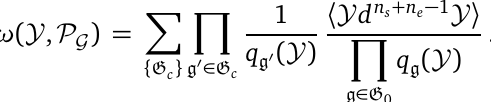
Figure 5: Higher codimension intersections of the facets outside P graphically obtained by considering a set of k < n marks the graph G in such a way that they do not share any